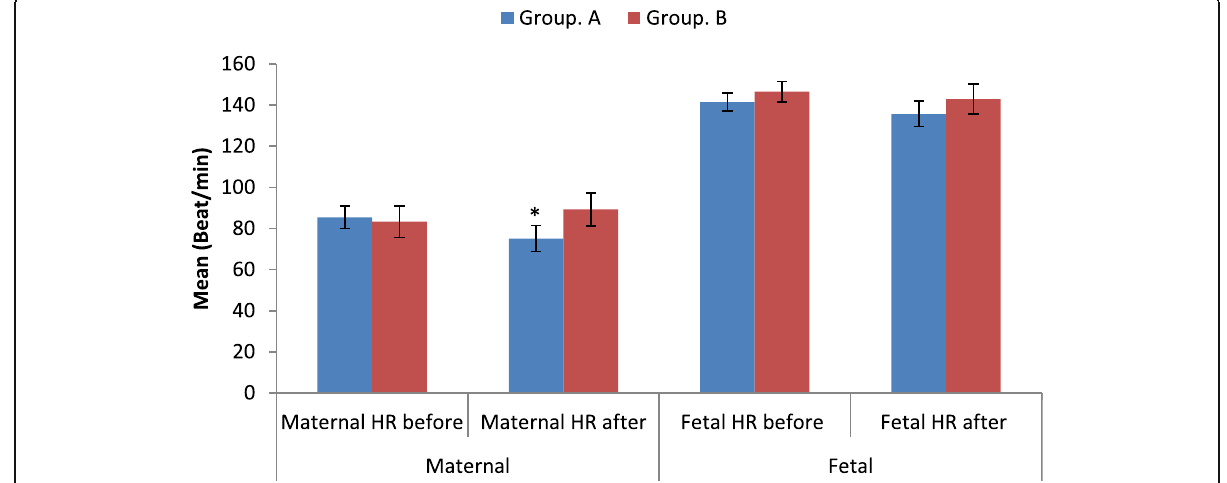
Fig. 2 Maternal and fetal heart rate before and after treatment in both groups. *Significant decrease from before